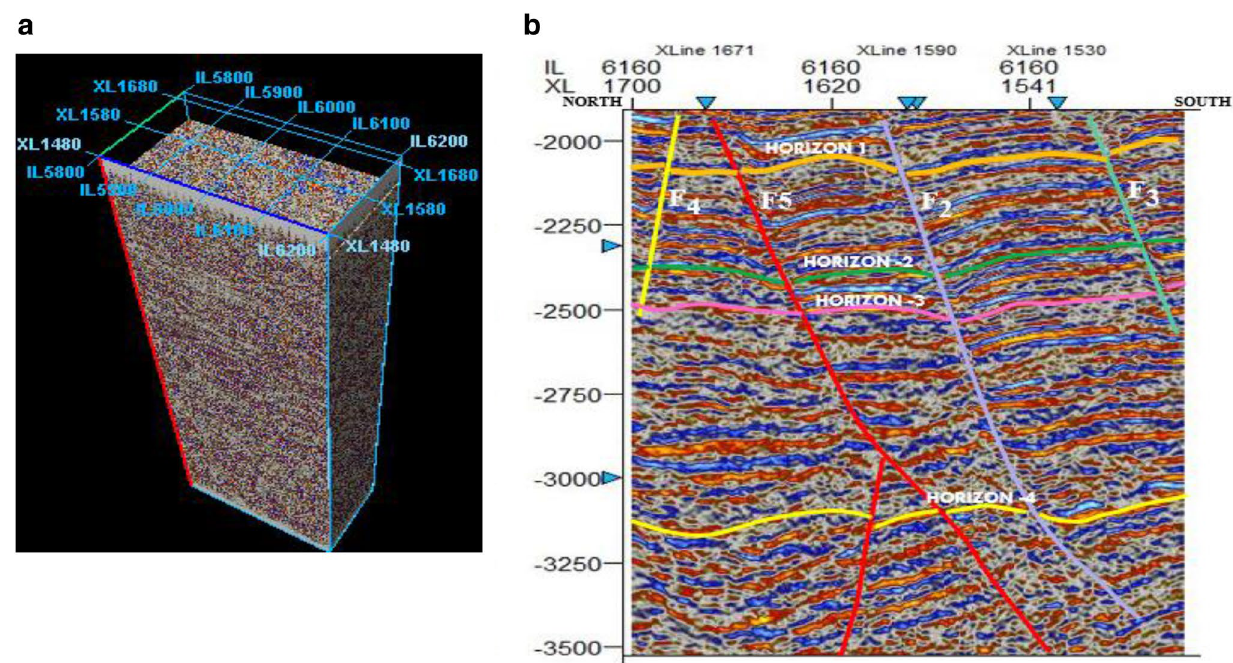
Fig. 8 a Seismic volume and horizons interpreted on the study. b Typical interpreted seismic section (Inline